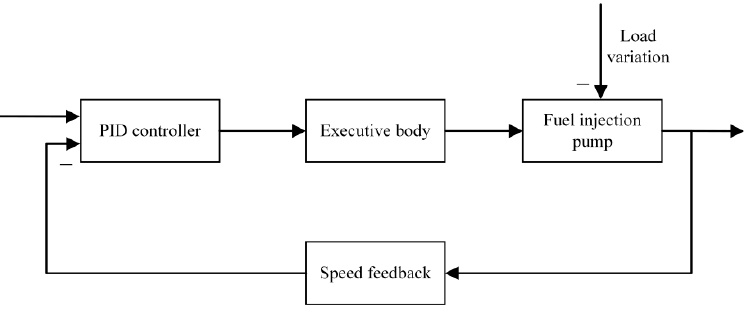
Figure 3. Block diagram of diesel engine speed regulation system.